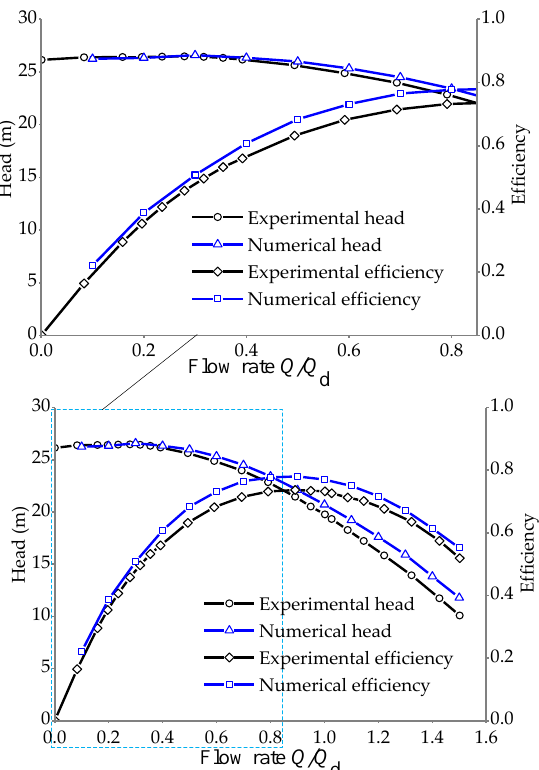
Figure 5. Performance curves of the centrifugal pump.